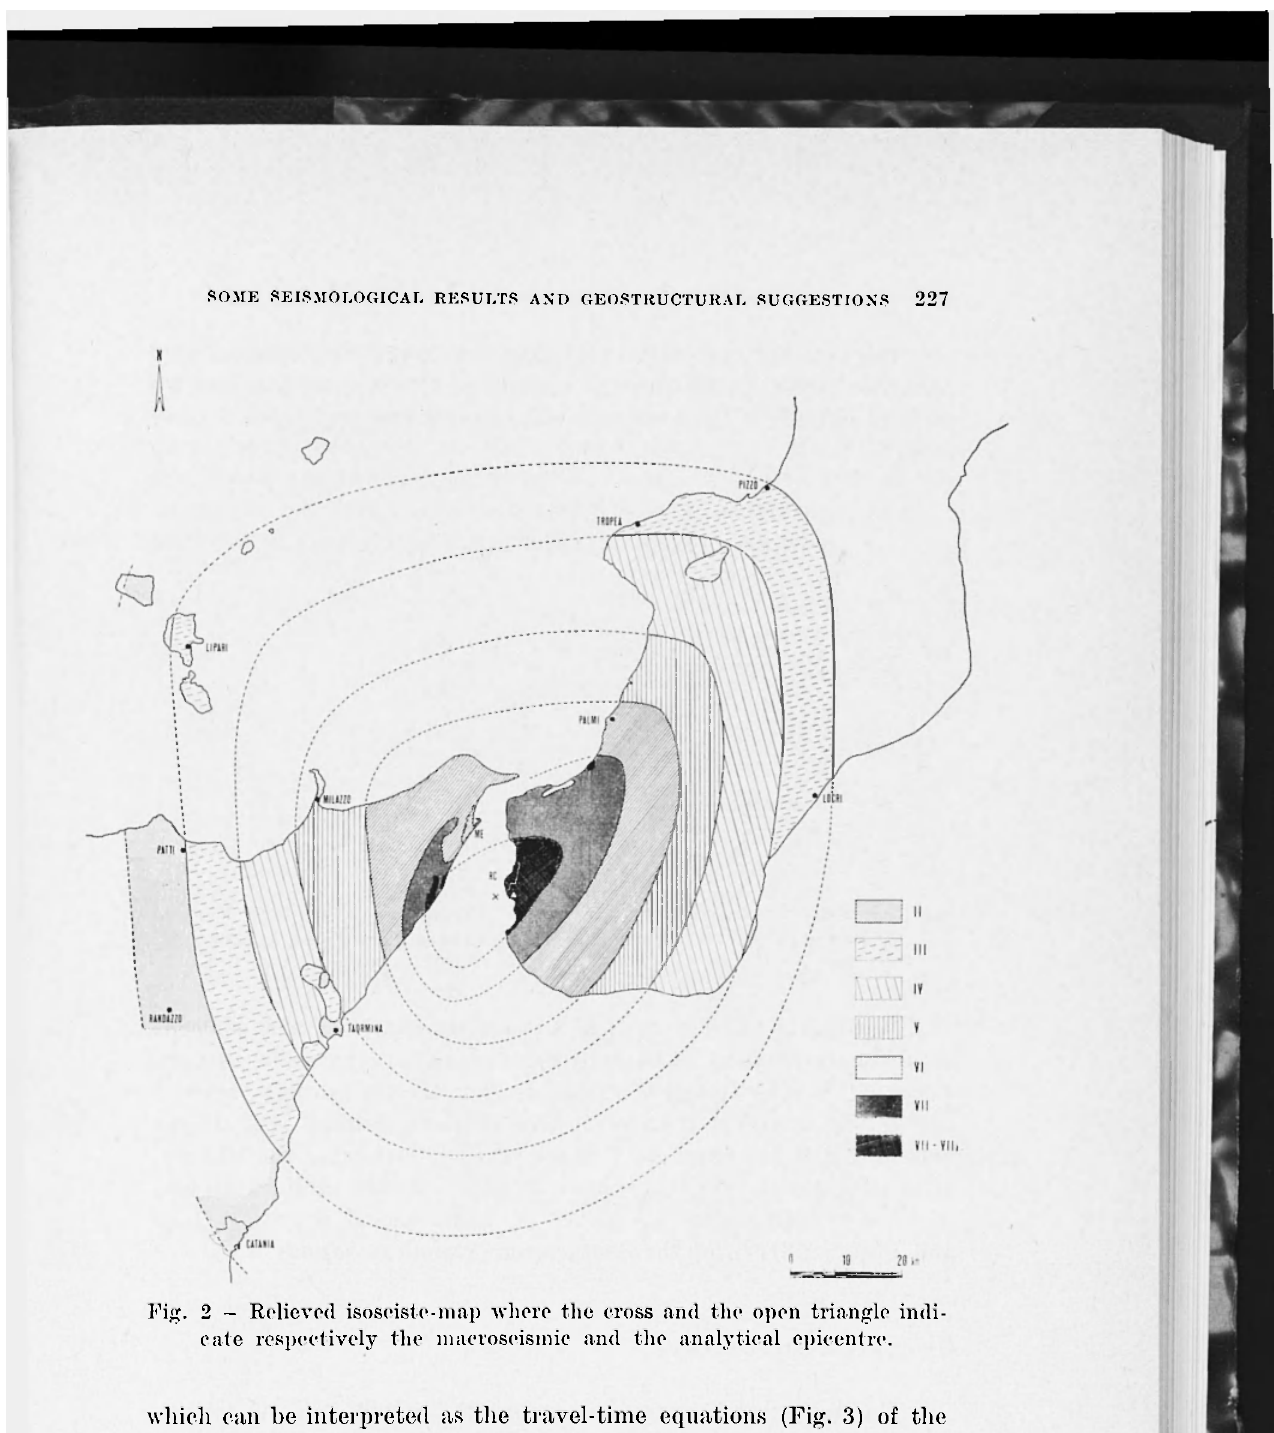
Fig. 2 - Relieved isoseiste-map where the cross and the open triangle indi- cate respectively the maeroseisinic and the analytical